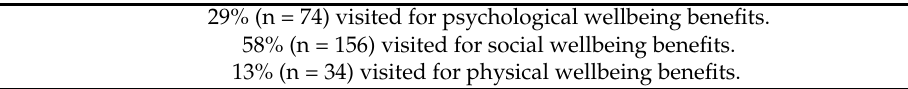
Table 6. Greenspace interaction benefits summary.